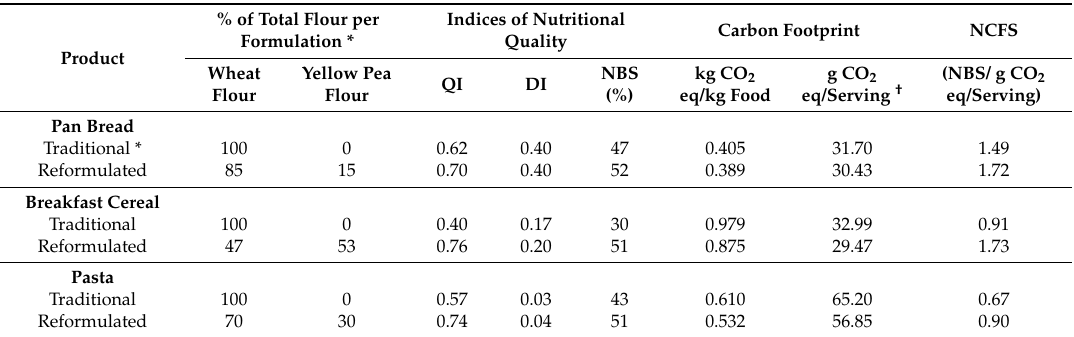
Table 3. The effect of reformulation with whole yellow pea flour on the nutritional profile and carbon footprint of pan bread, breakfast cereals, and pasta. % of Total Flour per Indices of Nutritional Carbon Footprint NCFS Formulation * Quality Product Wheat Yellow Pea Flour